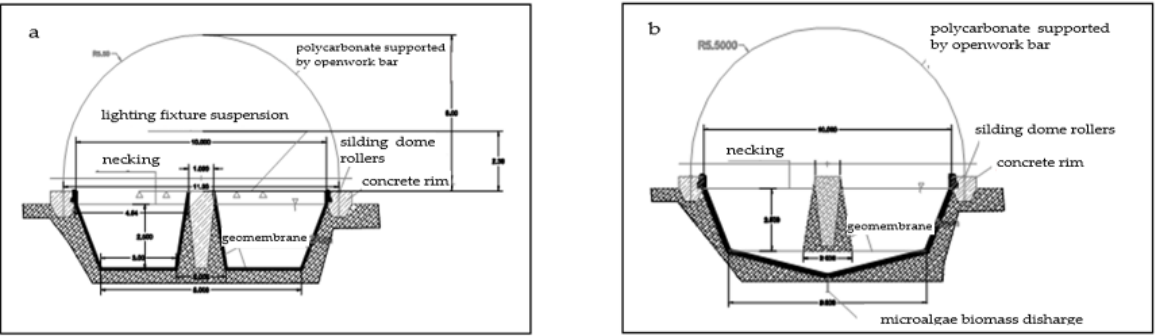
Figure 10. Cross-section views of the hybrid photobioreactor (( a )—A-A plane cross-section, ( b )—B- B plane